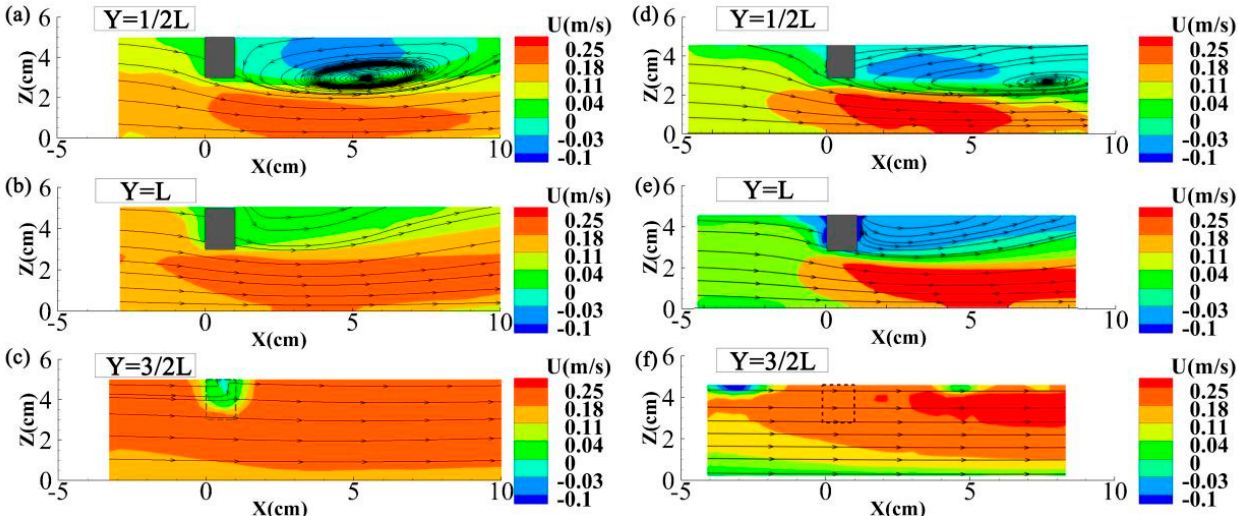
Figure 11. Distributions of velocity at longitudinal sections ( a ) Y = 1/2 L, ( b ) Y = L, ( c ) Y = 3/2 L in Case 5 (on the left) and at longitudinal sections ( d ) Y = 1/2 L, ( e ) Y = L, ( f ) Y = 3/2 L in Case 6 (on the right). The grey areas in subfigures ( a , b , d , e ) demonstrate the floating dike, and the dotted lines in subfigures ( c , f ) indicate the location of floating dike in the coordinate